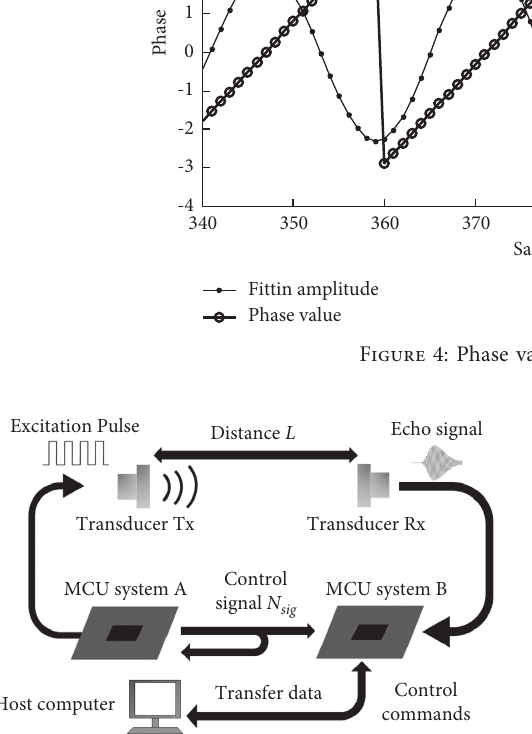
Figure 5: Ultrasonic ranging